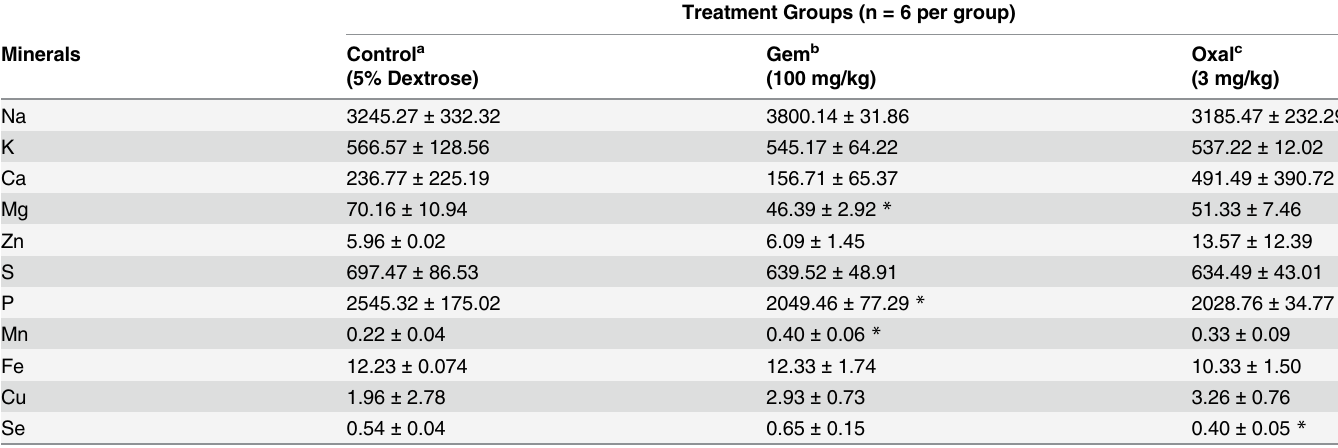
Table 2. Content of essential minerals in mouse DRG tissues ( μ g/g) after chemotherapy.